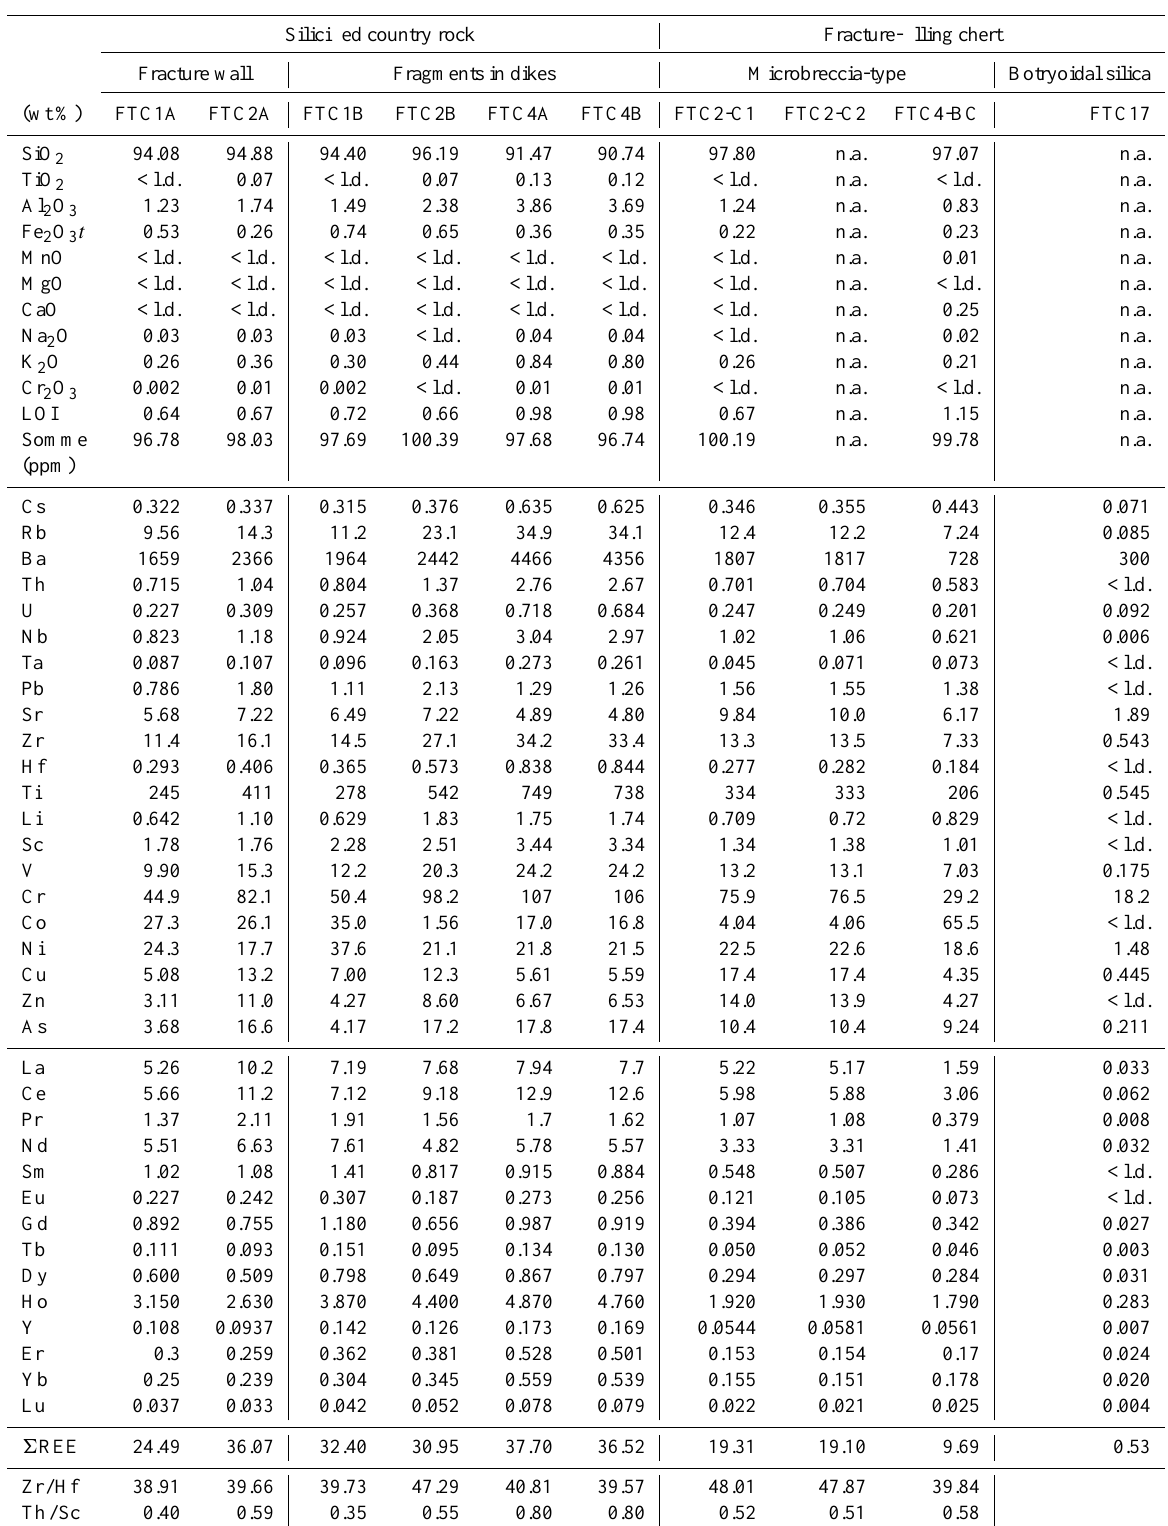
Table 1. Major and trace element analyses of Barite Valley silicified shales and fracture-filling cherts (<l.d. = below detection limit; n.a. = not